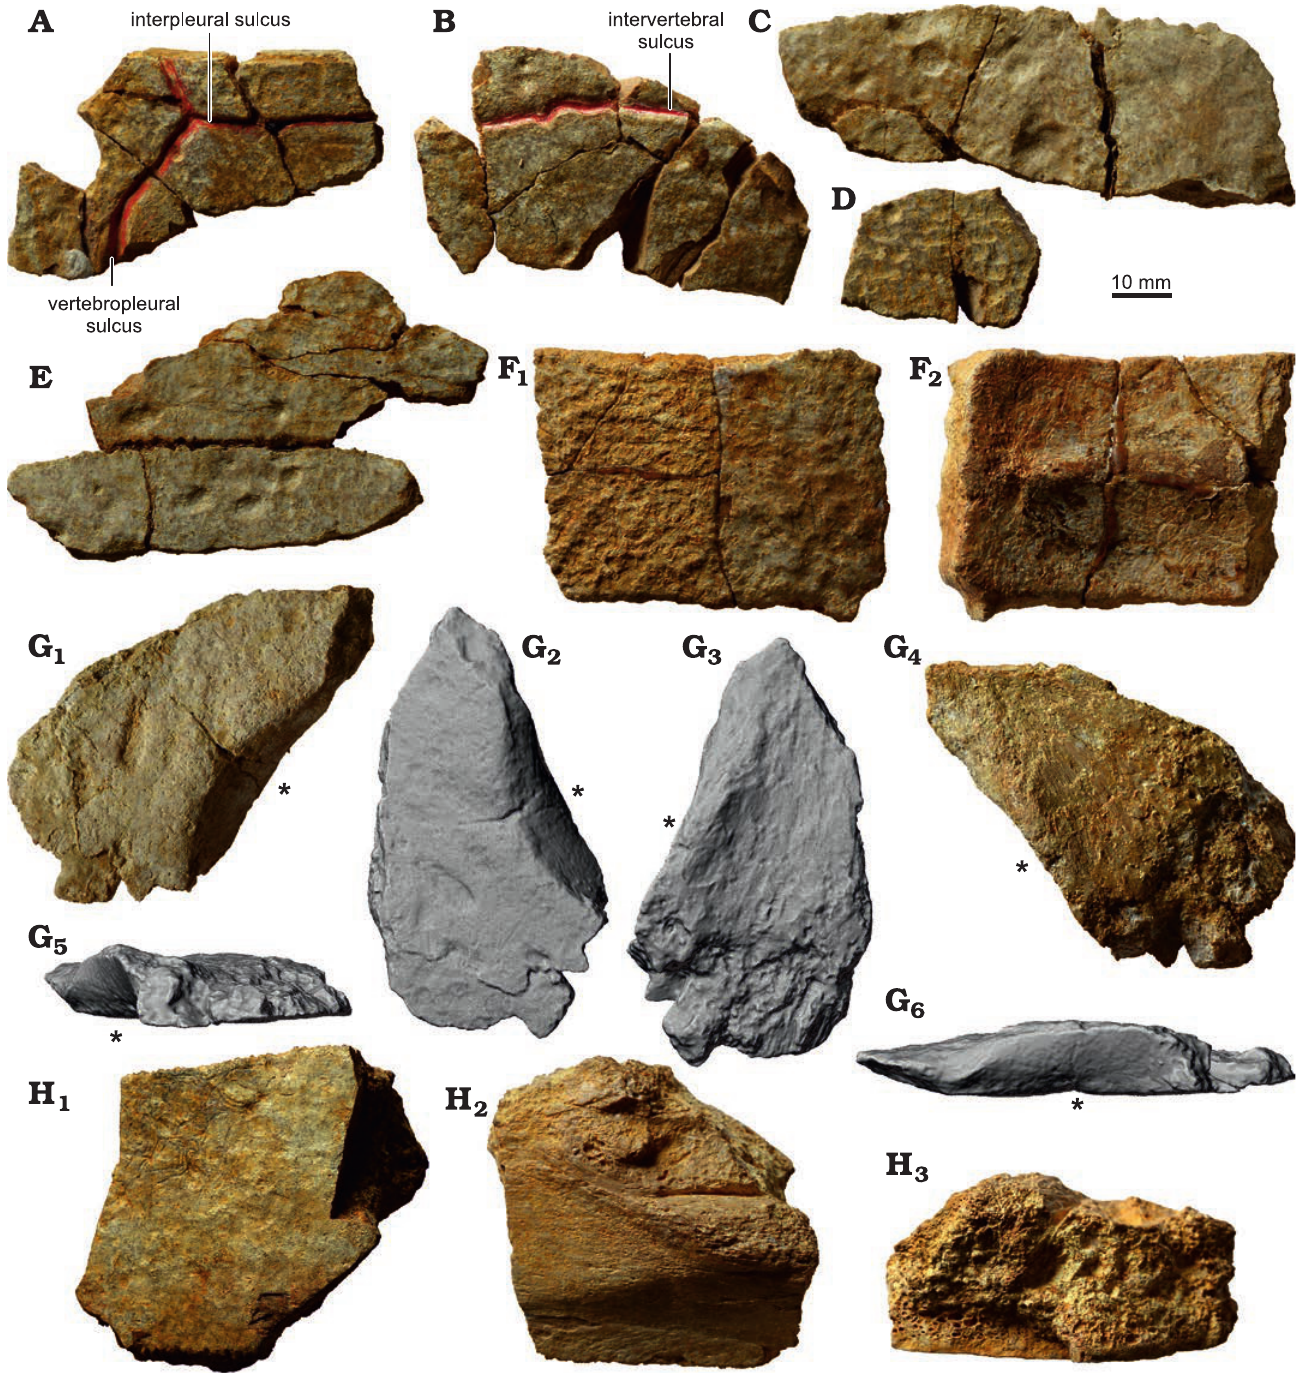
Fig. 5. The thalassochelydian turtle Craspedochelys ? sp., MZ VIII Vr-71, from the Kimmeridgian of Krzyżanowice, shell fragments. A . Middle part of a second, fourth, or sixth costal in external view. B . Proximal part of a third or fifth costal in external view. C , D . Parts of unidentified costals in external view. E . Parts of two unidentified costals retaining a sutural contact in external view. F . Proximal part of a second, fourth, or sixth costal in external (F 1 ) and visceral (F 2 ) views. G . Probable part of the plastron in external (G 1 –G 2 ), visceral (G 3 –G 4 ), ?posterior (G 5 ), and ?lateral (G 6 ) views. Note that the position of the element within the shell is uncertain, so precise orientation is not possible. G 2 , G 3 , G 5 , and G 6 are 3D models based on surface scans in the orthographic view with the Radiance Scaling shader enabled to optimize the lighting and present the raised ?lateral edge (asterisk). H . Part of a plastron of a large individual in external (H 1 ) and visceral (H 2 ) view and natural cross-section (H 3 ). Note that the fragments likely belong to various